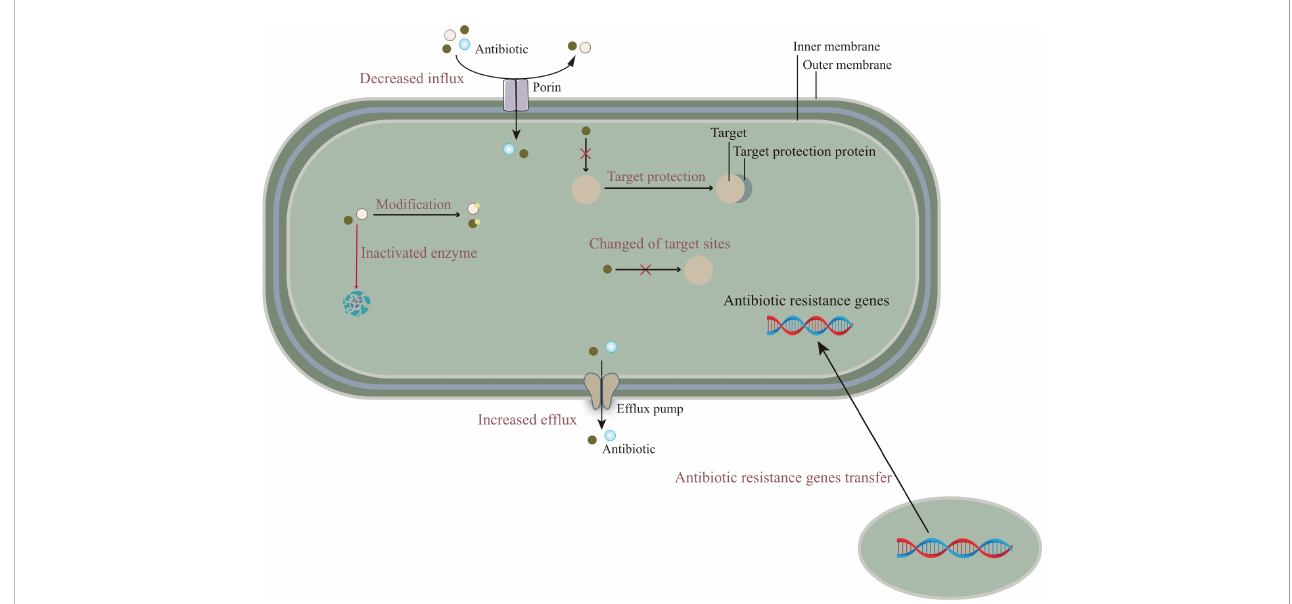
FIGURE 1 The molecular mechanisms of antibiotic resistance are mainly composed of the following: (i) Reducing the entry of antibiotics, that is, down-regulation of porin expression; Or promote the ef fl ux pump to discharge antibiotics. (ii) The resistance gene is transferred from other pathogens to the target bacteria to enhance the antibiotic resistance of the target bacteria. (iii) The mutation of gene target site reduces the af fi nity between antibiotics and target sites or cannot combine with them. In addition, related proteins can also protect target sites and prevent the binding of antibiotics. (iv) Antibiotics are modi fi ed or degraded by related